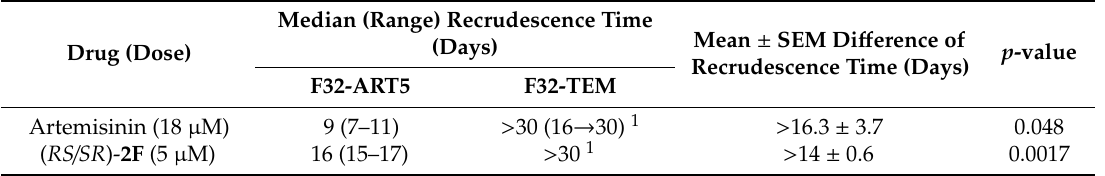
Recrudescence assay on artemisinin-resistant (F32-ART5) and artemisinin-sensitive (F32-TEM) strains.